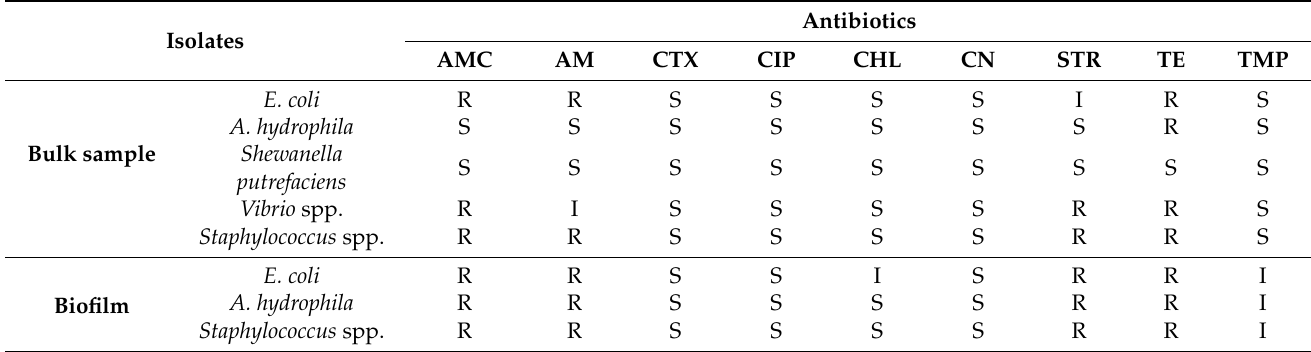
Table 3. Antibiotics susceptibility pattern of the isolates from silver carp.